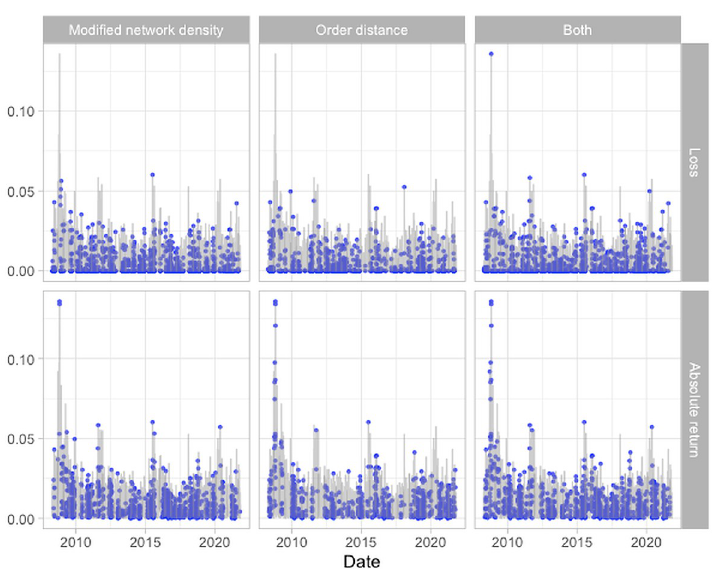
Fig 9. Time series plots of the loss and absolute return of the HSI, with blue dots indicating the data that are significant in the Granger-causality tests on the time points marked on the x -axis. There are six tests, the rows indicate the responses (loss and absolute return) and the columns represent the independent variables (Modified network density, order distance, and both of them) used in the Granger-causality